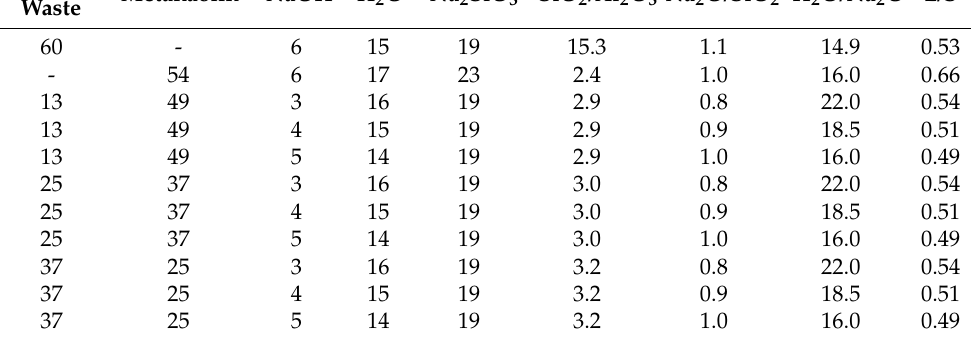
Table 3. Typical mix proportions (wt. %) of raw materials and reagents. The last four columns show the molar ratios SiO 2 /Al 2 O 3 in the starting mixture as well as the Na 2 O/SiO 2 and H 2 O/Na 2 O molar ratios in the activating solution and the overall liquid/solid (L/S)